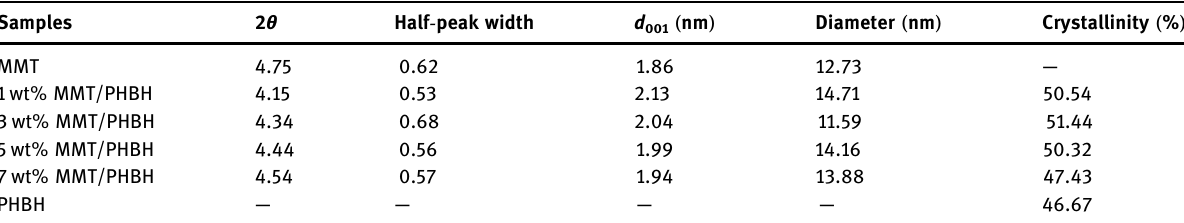
Table 1: The X - ray di ff raction data of MMT, PHBH, and MMT/PHBH biocomposites Samples